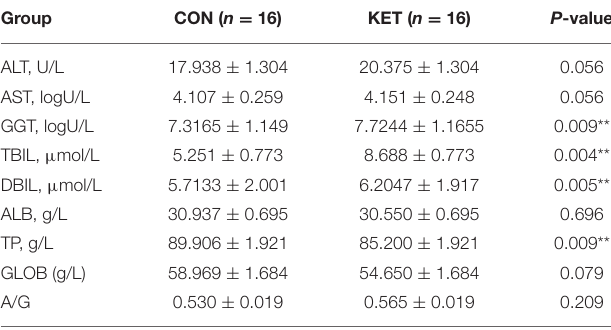
TABLE 5 | Comparison of LFT indices in ketotic and healthy CON dairy